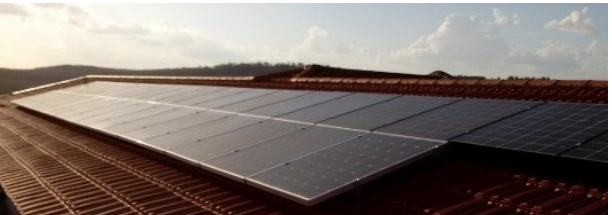
Figure 2. Roof mounted PV system.